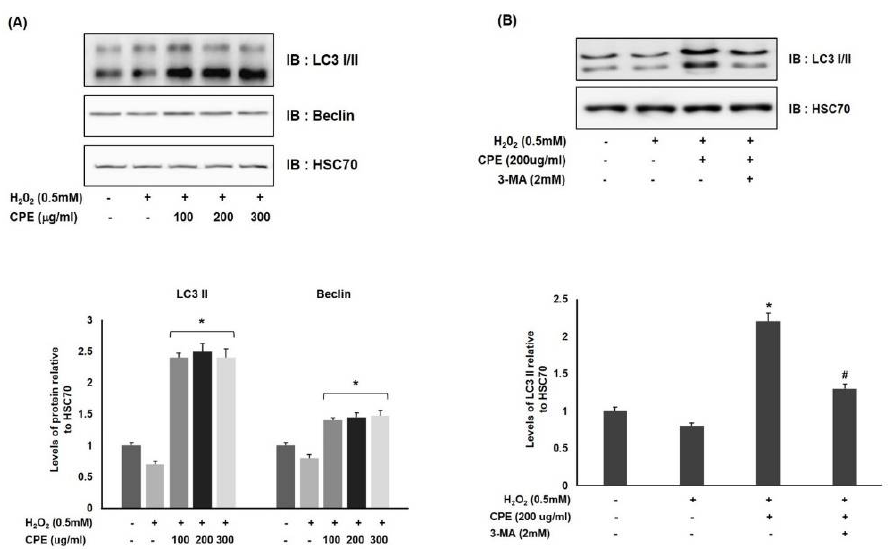
Figure 4. CPE protects melanocytes by activation of autophagy, protecting against H 2 O 2 -induced oxidative stress. ( A ) The Melan-a cells were first treated with CPE for 1 h and then with H 2 O 2 for 24 h. Cells were harvested and subjected to Western blot analysis with LC3 and Beclin antibodies. ( B ) The Melan-a cells were treated with H 2 O 2 or CPE in the presence and absence of 3-MA. All data are shown as the means ± SDs of at least three independent experiments (* p <0.05 vs. NT, # p <0.05 vs. H 2 O 2 treated cells).